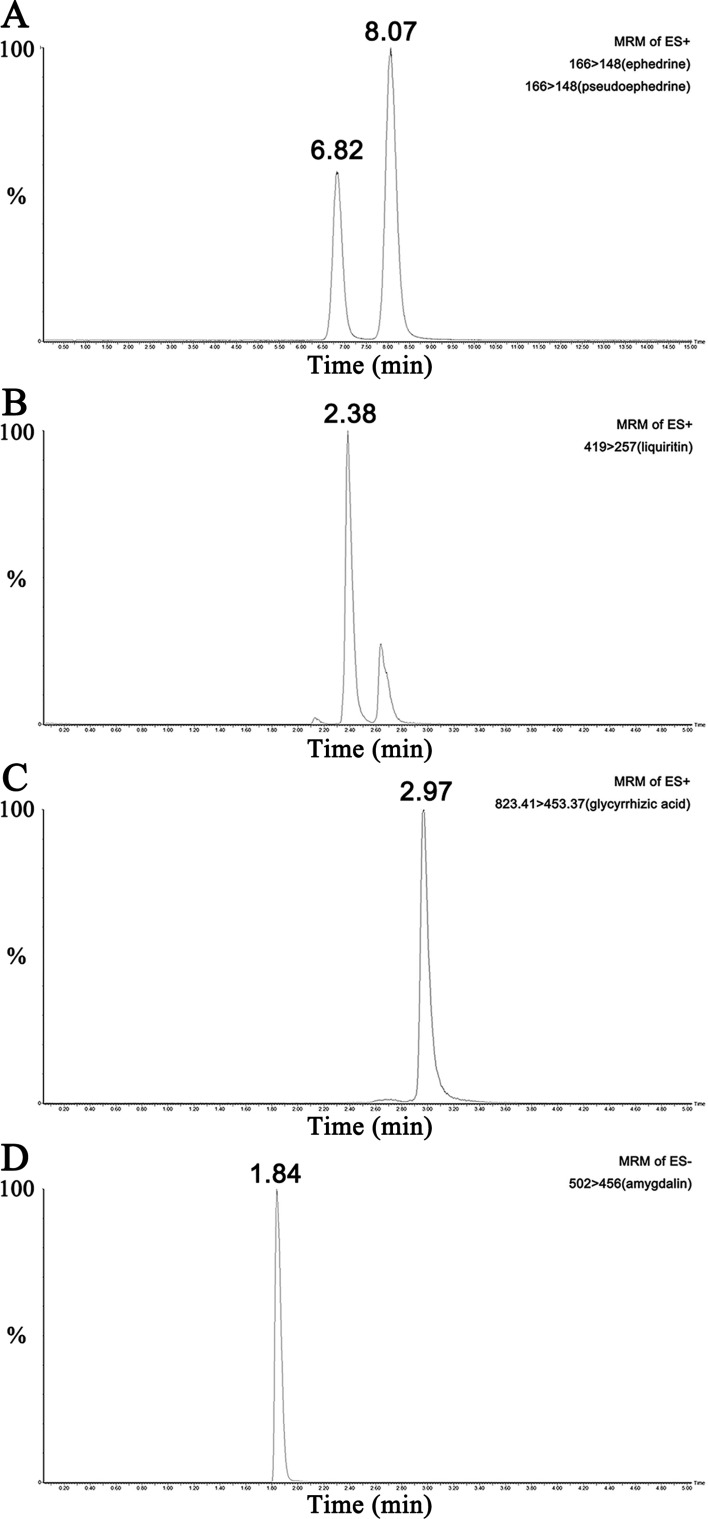
Representative chromatograms of the five compounds in MXD sample. (A) Representative chromatograms of ephedrine and pseudoephedrine in MXD sample. (B) Representative chromatogram of liquiritin in MXD sample. (C) Representative chromatogram of glycyrrhizic acid in MXD sample. (D) Representative chromatogram of amygdalin in MXD sample.